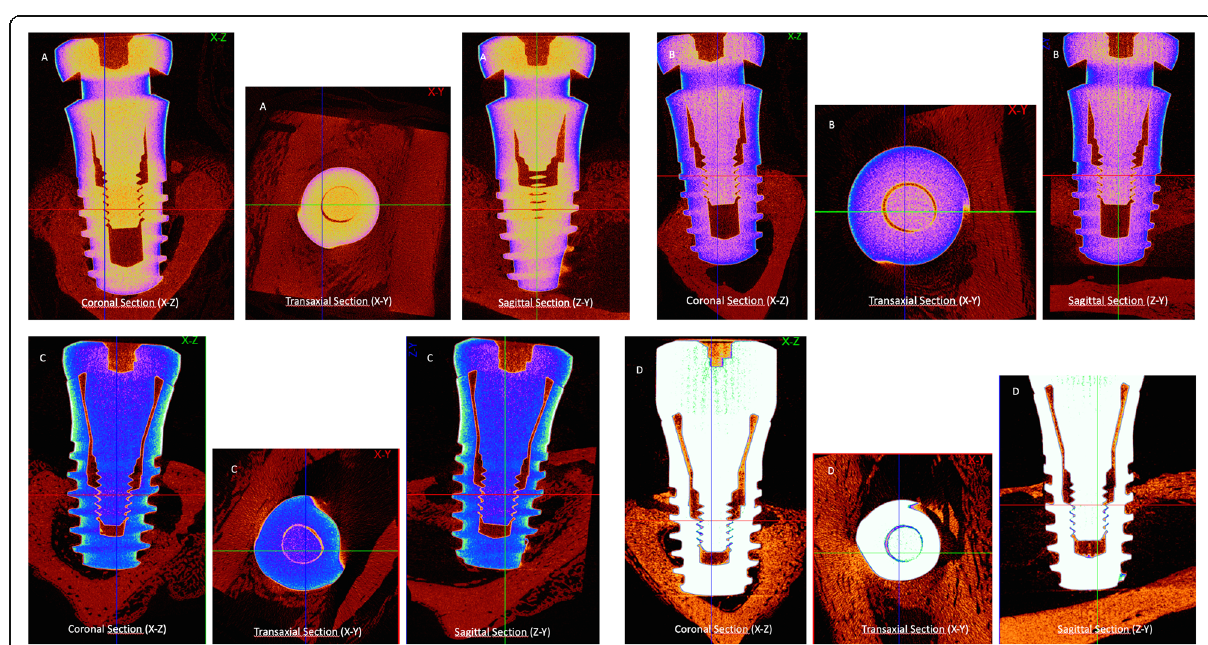
Fig. 2 Images of coronal (X-Z), transaxial (X-Y), and sagittal (Z-Y) sections of the groups in the micro-CT scans. Note the bone implant contact differences among the groups. a ShamOVX-LLLT, b ShamOVX, c OVX-LLLT, and d OVX